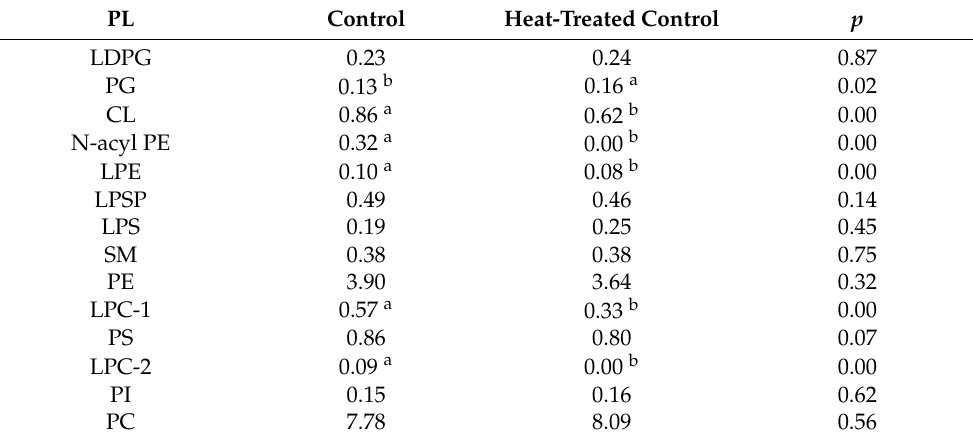
Table 4. Extracted phospholipid composition of